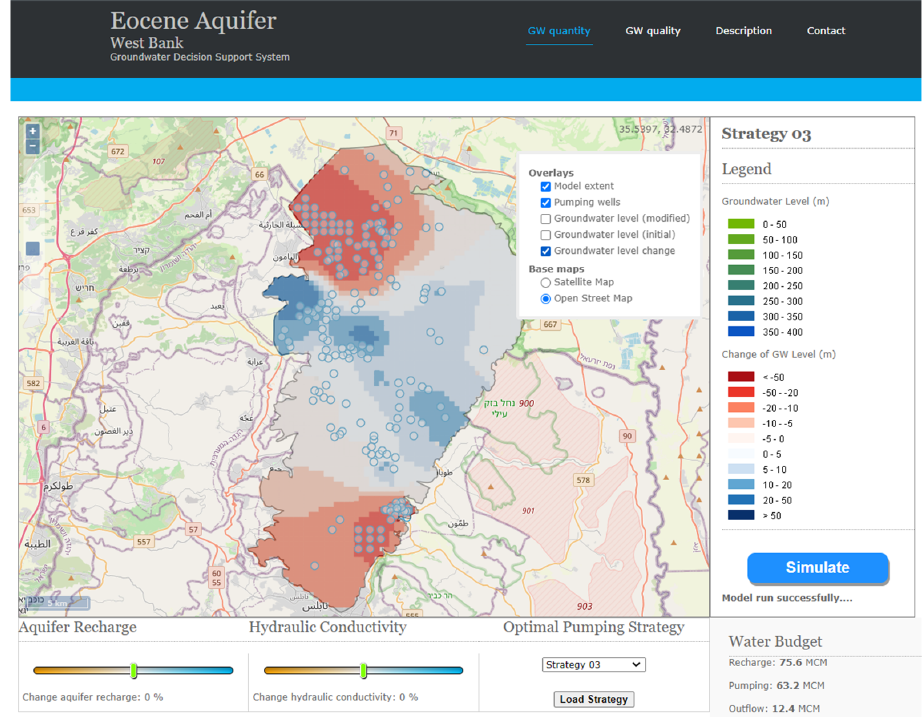
Figure 29. Groundwater head change for Strategy 03 compared to present conditions.